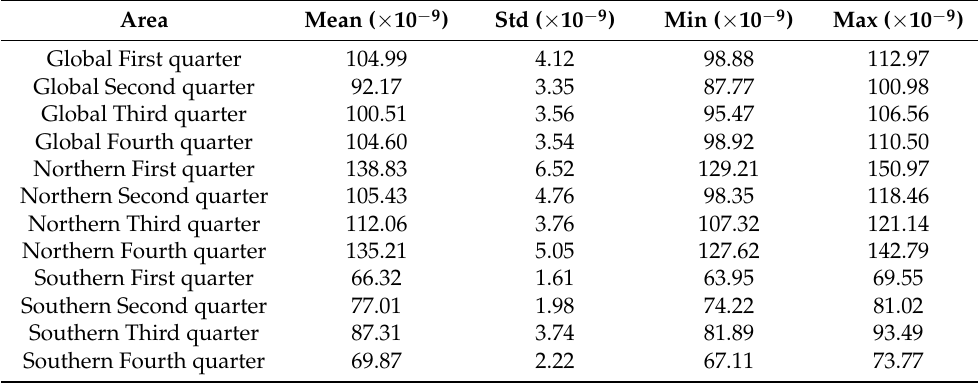
Table 1. Mean value, standard deviation, and minimum value and maximum value of CO concentra- tion during the four seasons of the world, northern hemisphere and southern hemisphere from 2002 to